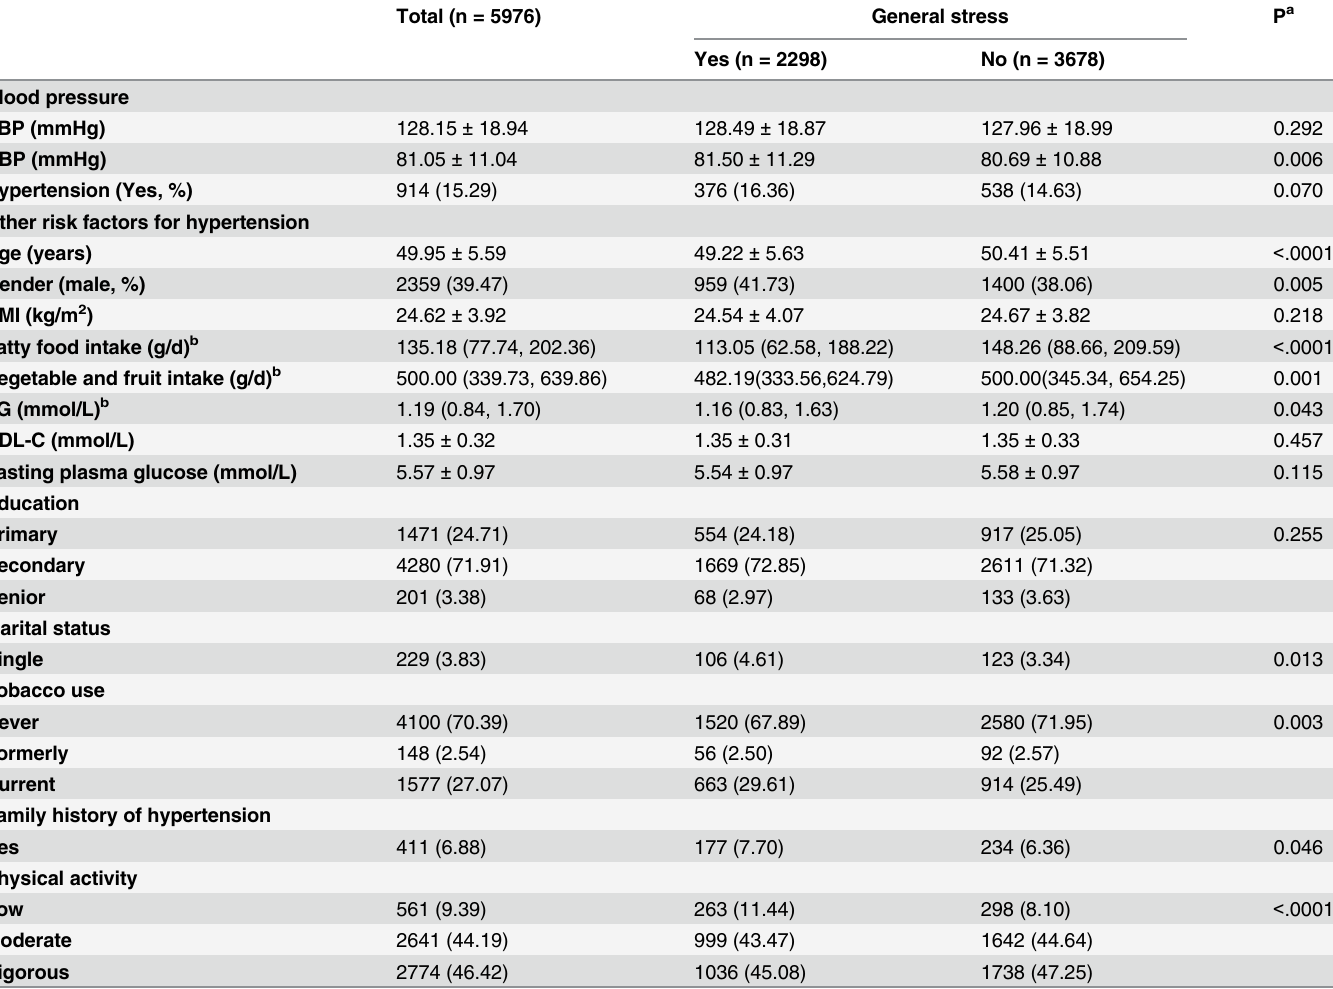
Table 1. Demographic characteristics of participants by general stress. Total (n = 5976) General